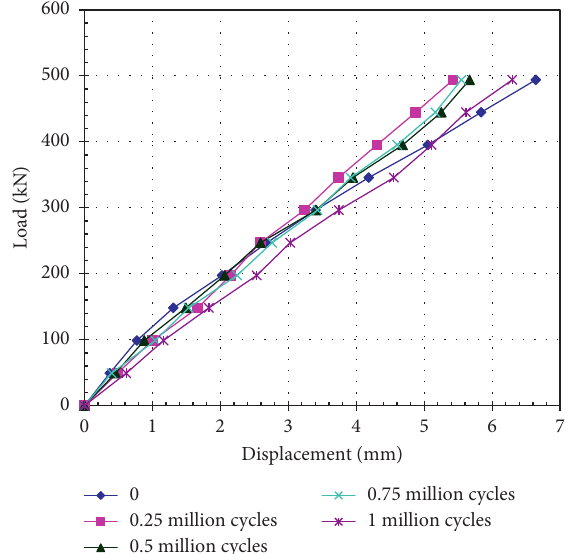
Figure 21: Comparison of midspan load-displacement curves (after dynamic loading of PLG-1).